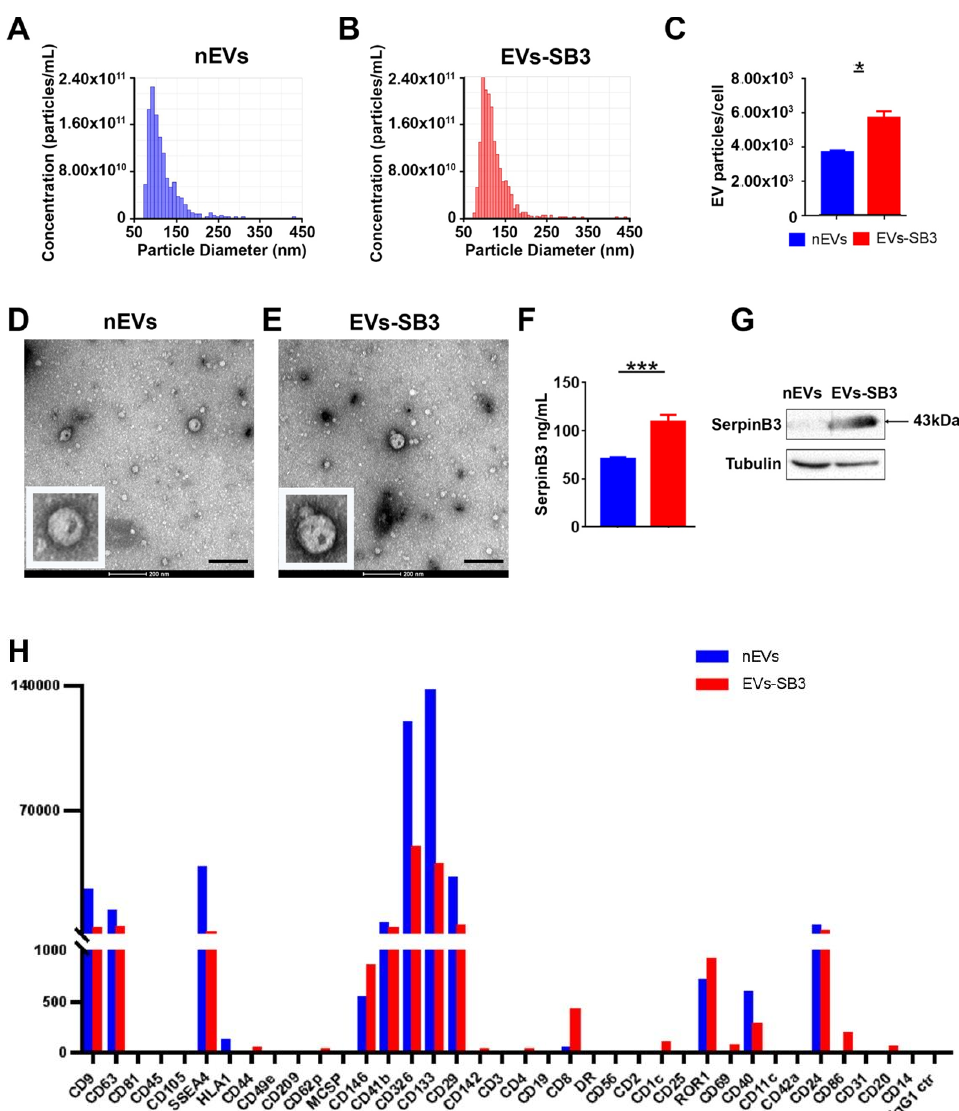
Figure 2. Characterization of extracellular vesicles derived from HepG2s. Representative size distribution of naïve EVs (nEVs) ( A ) and of EVs-SB3 ( B ) analysed by Resistive Pulse Sensing. ( C ) Number of nEVs and of EV-SB3 secreted per cell. Result are mean ± standard error ( n = 5 independent experiments), * p < 0.05. Transmission electron microscopy analysis of freshly nEVs ( D ) and of freshly EVs-SB3 ( E ); scale bar refers to 200 nm. ( F ) SerpinB3 quantification by ELISA assay. Result are mean ± standard error ( n = 5 independent experiments), *** p < 0.001. ( G ) Western Blot of nEVs and EVs-SB3 for SerpinB3. ( H ) Distribution of surface biomarker expression in nEVs and in EV-SB3.